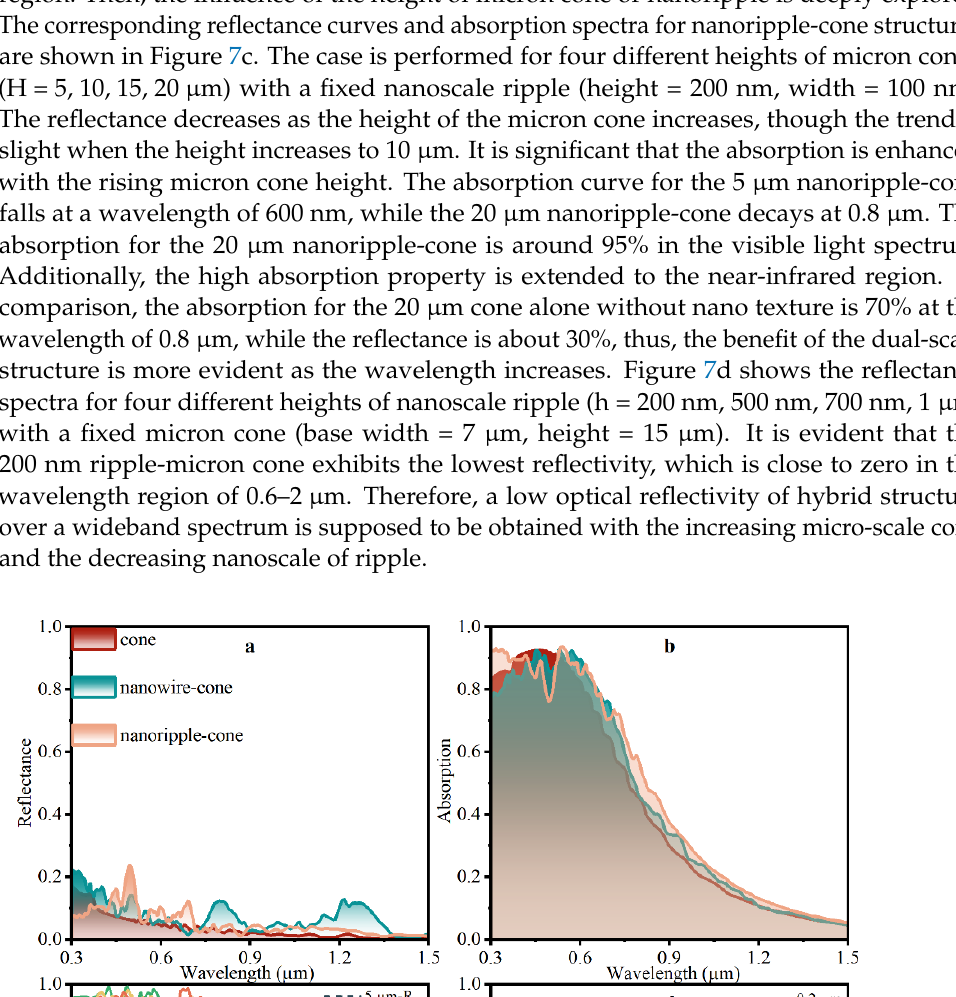
Figure 8. Reflectance spectra for ( a ) the 5 µm nanoripple-cone and ( b ) the 20 µm nanoripple-cone over the incident angle from 0° to 60° as a function of wavelength from 0.3 – 0.9 µm, as well ( c ) for the 20 µm nanoripple-cone in the NIR region. We have studied the dependence of reflectivity on the shape and height size of struc- ture fabricated on silicon. The nanoripple-micron cone is proposed to reduce reflectivity and enhance efficiency of devices. The hierarchical texture consists of both nanoscale and micron-scale. The nanoscale ripple, which is smaller than wavelength, has an influence to reduce reflection and enhance light coupling because of the refractive index grating effect [44]. At the air – solid interface, the nano texture works as a medium and the reflective index changes from 0 (for air) to 3.8 (for bulk silicon) as the light is trapped in structures.